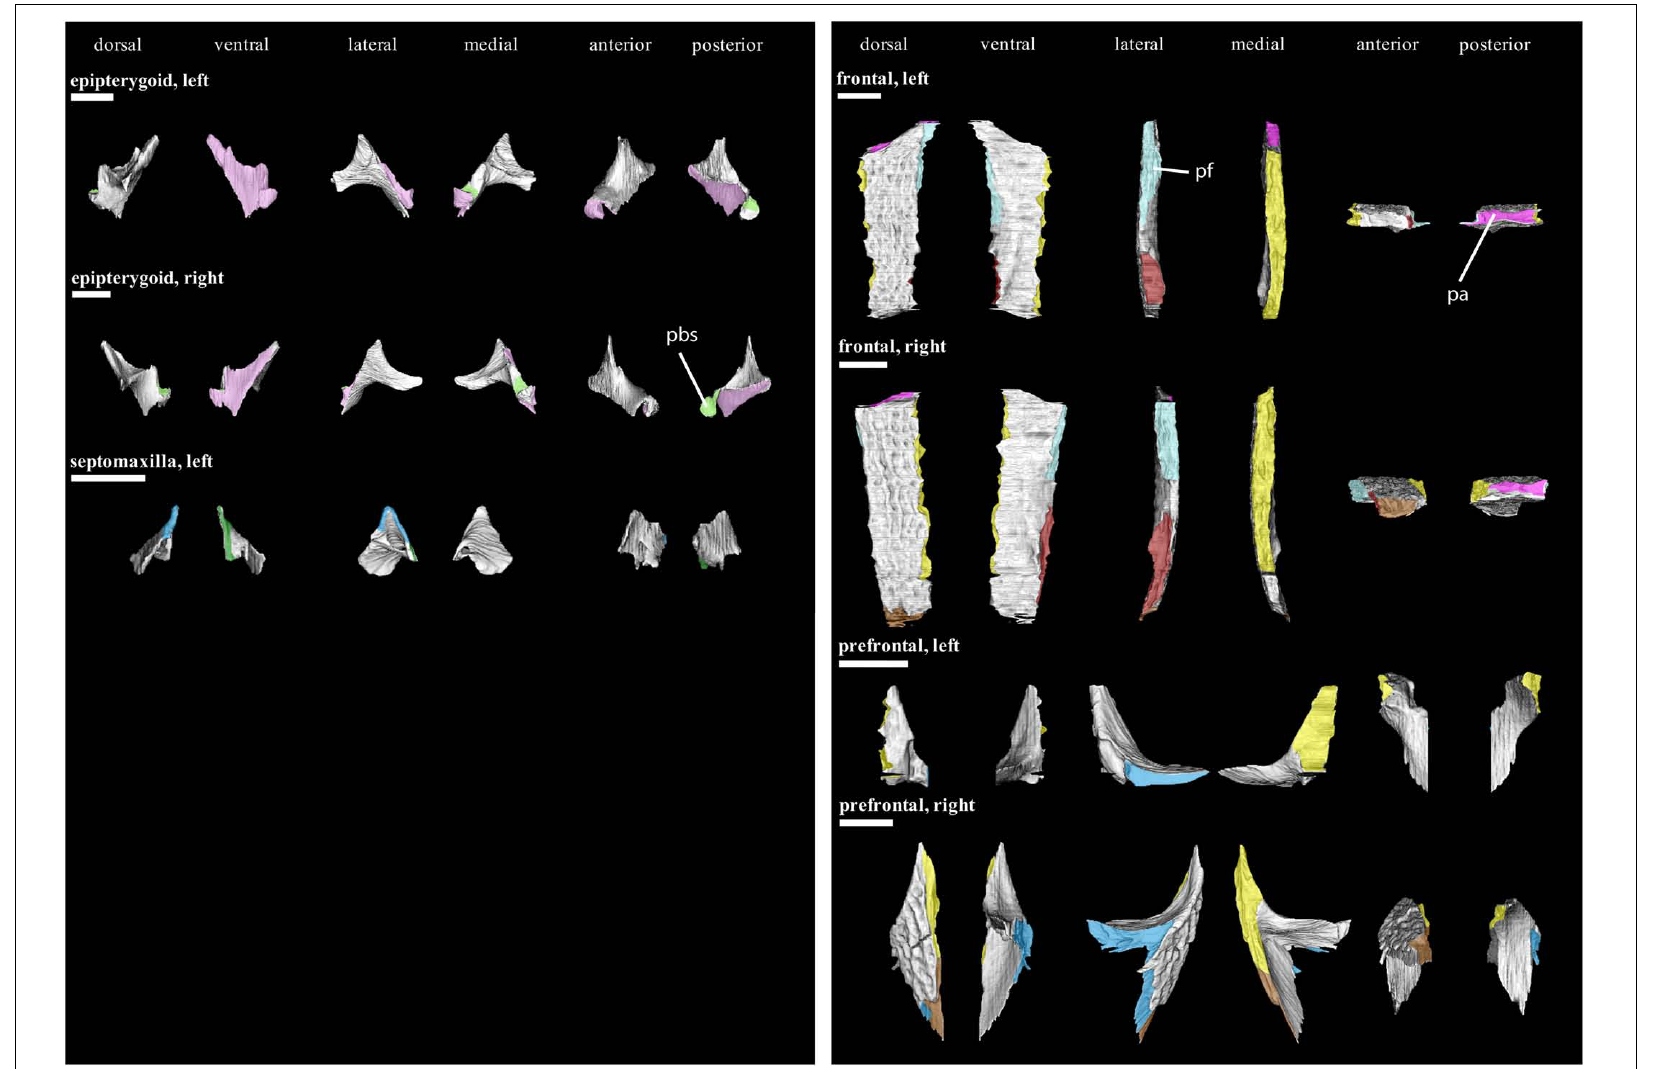
FIGURE 6 | Isolated bones in dorsal, ventral, lateral, medial, anterior and posterior views. Articulation areas with other bones are colored. Left and right epipterygoid, left septomaxilla, left and right frontal, and left and right prefrontal are shown. Scale bar = 10 mm. For abbreviations see caption to Figure 1